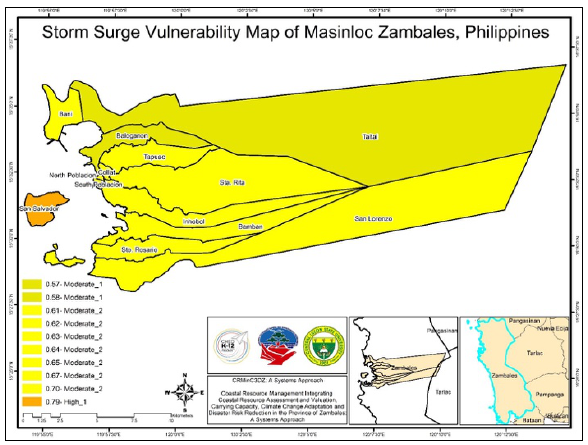
Figure 2. Storm surge vulnerability map of Masinloc, Zambales,